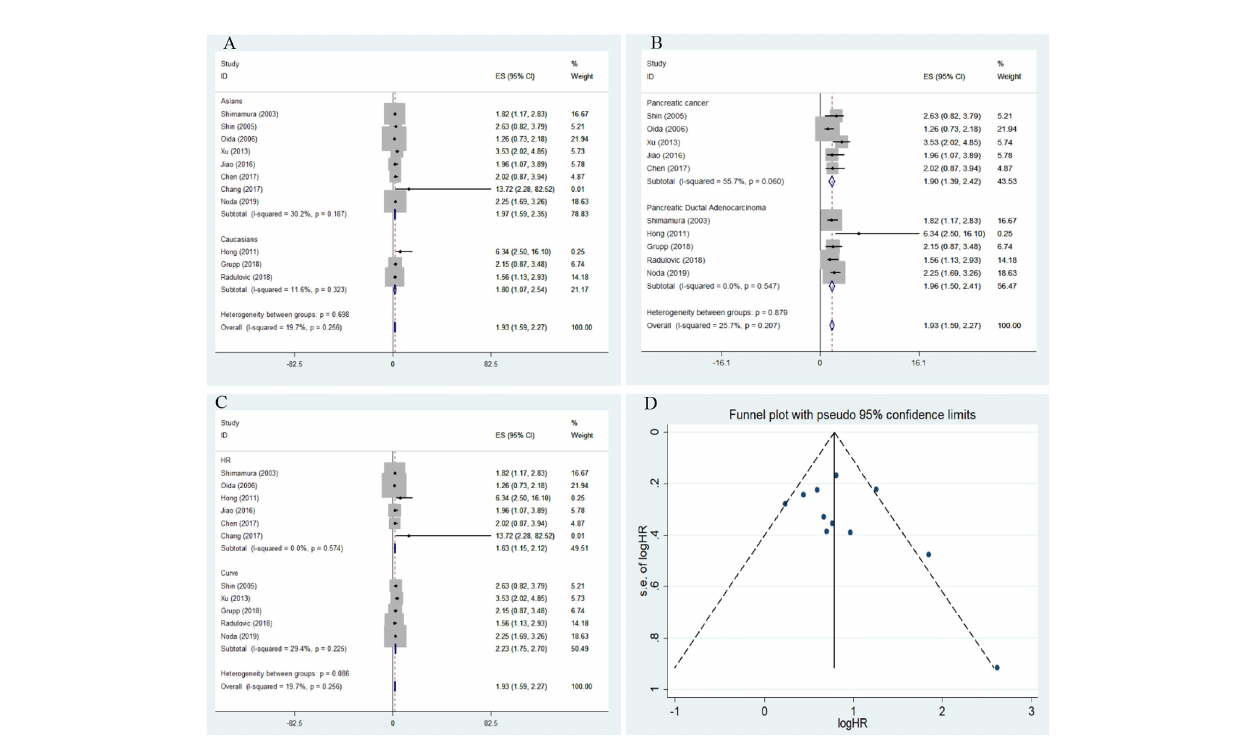
FIGURE 2 | Forest plot and funnel plot for the association between E-cadherin expression and overall survival of pancreatic cancer. (A) subgroup analysis for ethnicity; (B) subgroup analysis for cancer subtype; (C) subgroup analysis for the source of hazard ratios (HRs); (D) funnel plot for the association between E- cadherin expression and overall survival of pancreatic cancer.